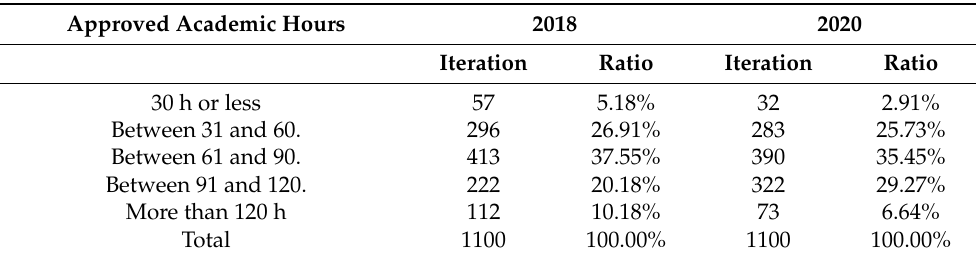
Table 5. Distribution of student numbers by approved academic hours in 2018 and 2020.